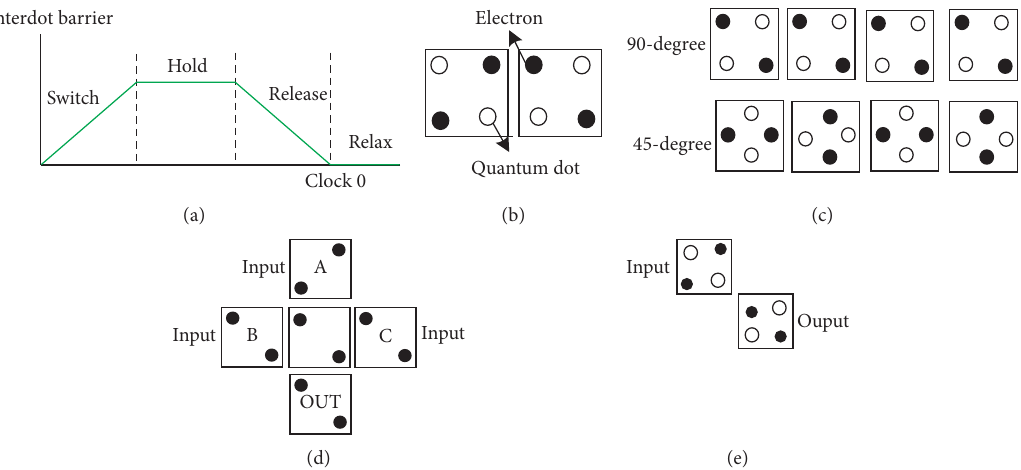
Figure 1: (a) The four-phase clocking scheme. (b) The logical states defined by the electron configuration for the QCA cell consisting of four quantum dots, (c) A binary wire that can be achieved by two cell layouts. (d) The majority gate with three inputs and the single output with a binary state decided by majority voting behaviour, (e) The Inverter that is achieved by placing the two cells